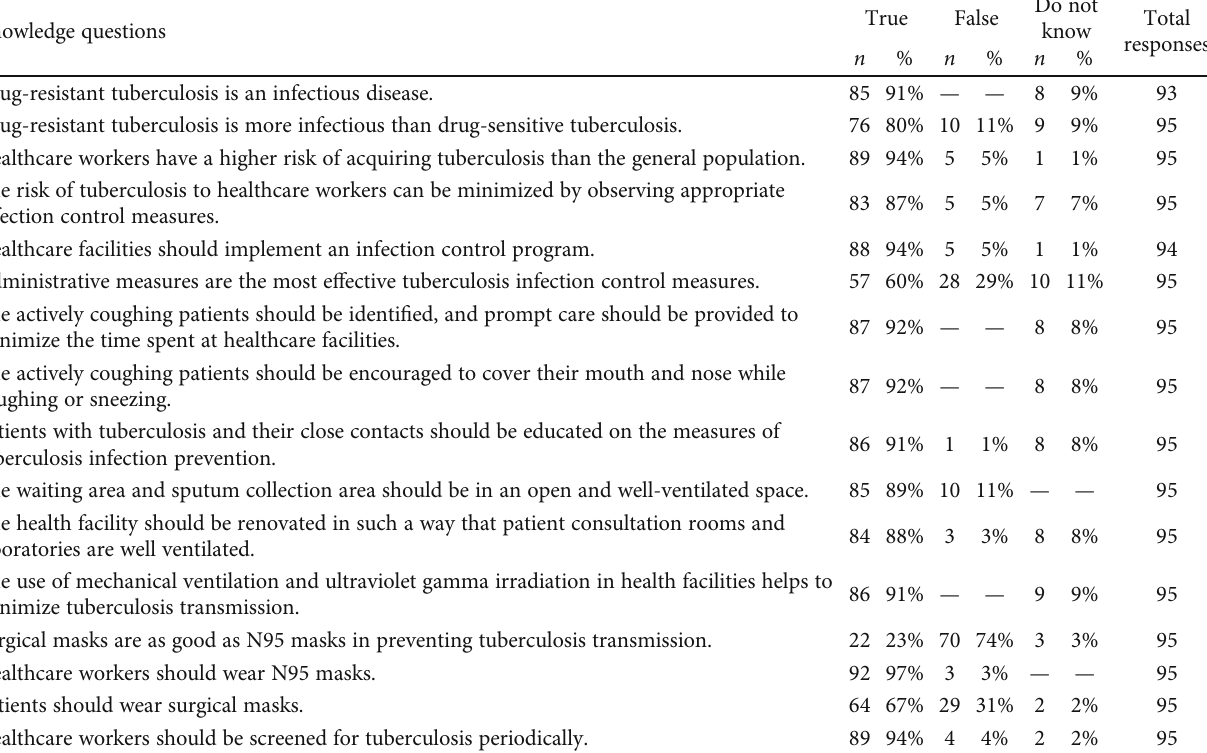
Table 2: Knowledge questions on drug-resistant tuberculosis infection control and the responses from the study participants. Knowledge questions